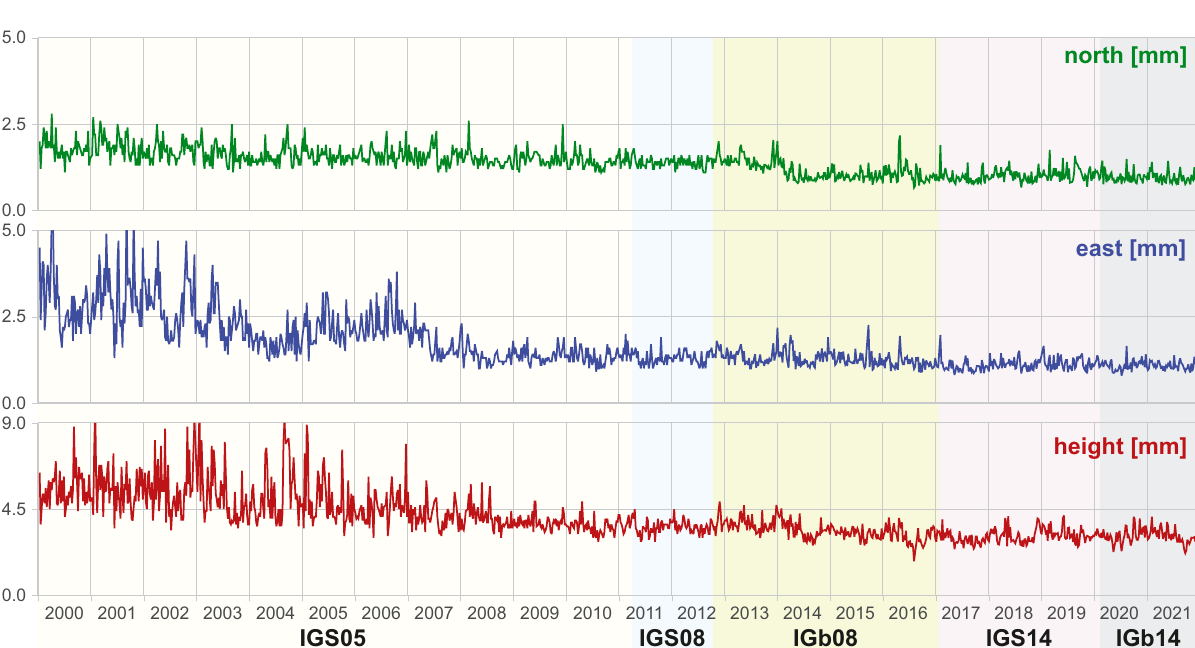
Figure 9: Mean RMS values of the station position residuals obtained after comparing the SIRGAS combined solutions between consecutive weeks. Background colours indicate the IGS reference frame in